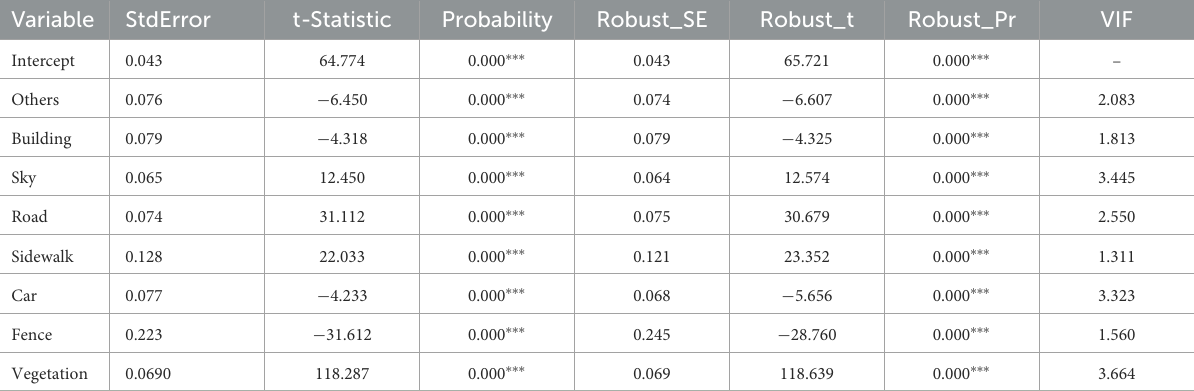
TABLE 3 Summary of OLS results (model